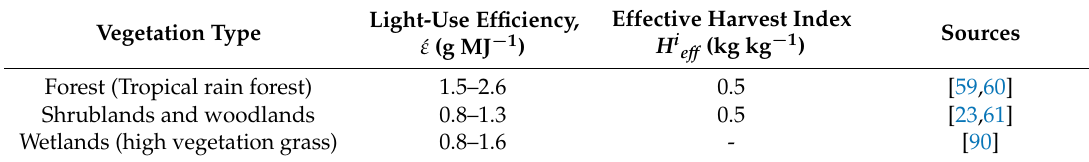
Table 4. Maximum light-use efficiency and the harvest index for natural land